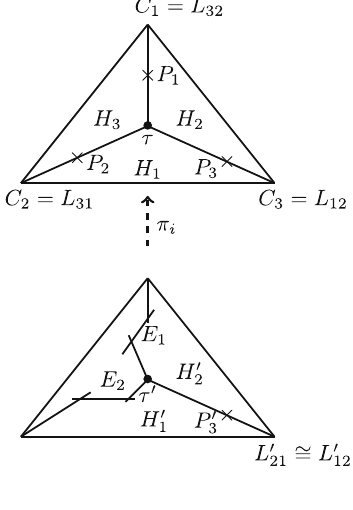
Figure 2: The Blow - up π i